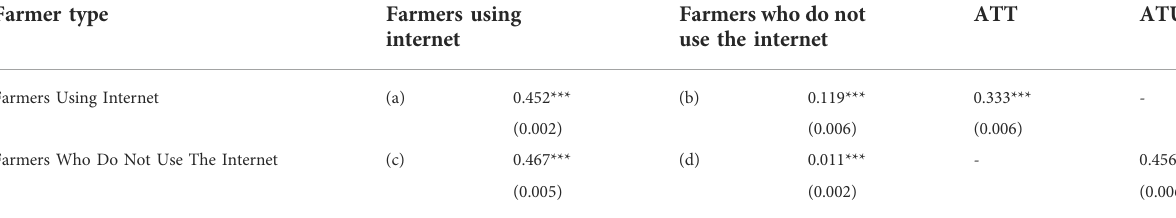
TABLE 4 The average treatment effect of the Internet use on agricultural GPE.